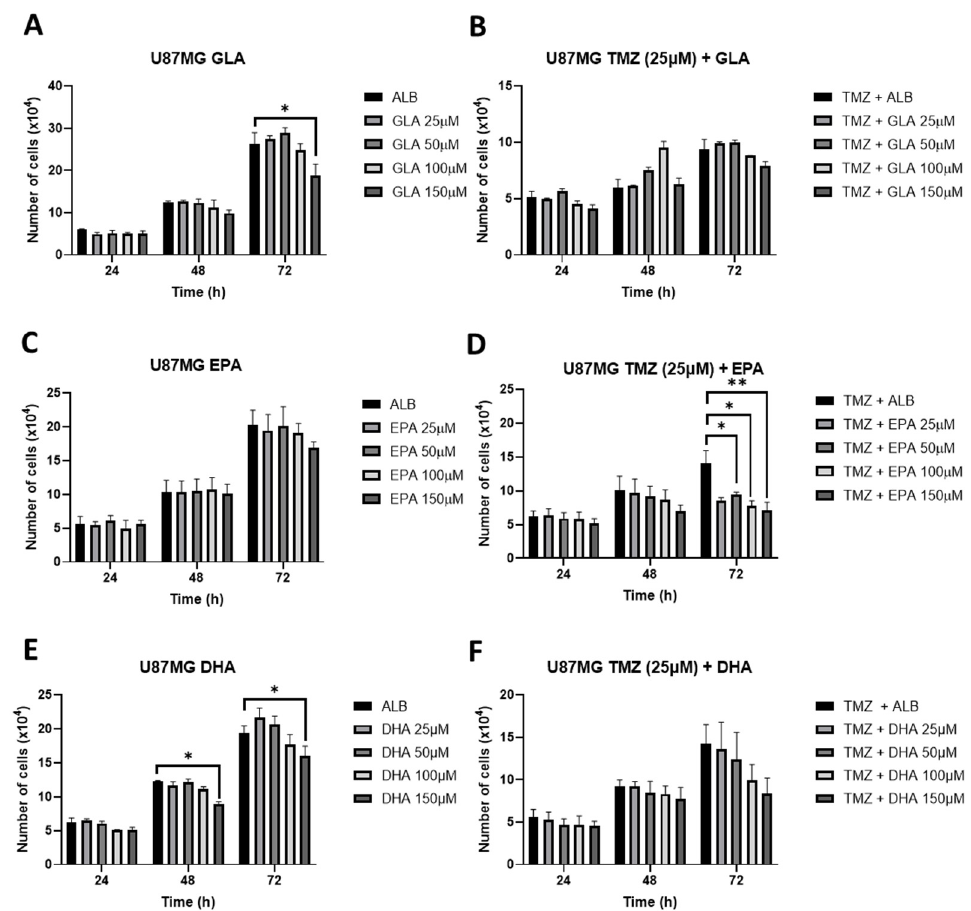
Figure 3. Effects of gamma-linolenic acid (GLA), eicosapentaenoic acid (EPA), and docosahexaenoic acid (DHA) on U87MG cell counts: ( A , C , E ) Graphs show the results after 24, 48, or 72 h of treatment with PUFAs. ( B , D , F ) Graphs show the results after 24, 48 or 72 h of treatment with PUFAs in the presence of TMZ. Data are presented as mean ± SEM, N = 3. Differences were considered significant at p < 0.05. * = p < 0.05; ** = p < 0.01.